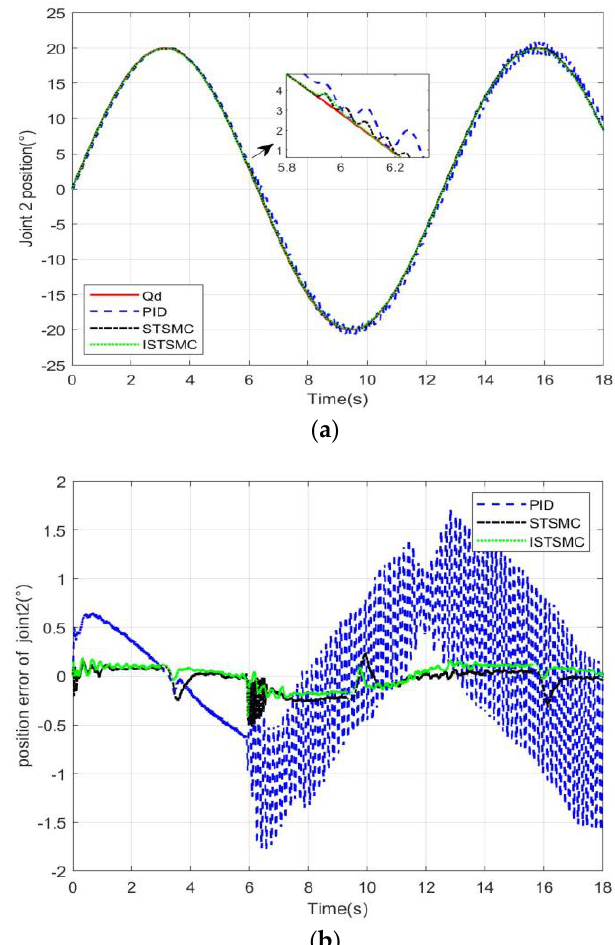
Figure 4. Joint 2 is suddenly disturbed at 5.9 s. ( a ) Trajectory tracking diagram; ( b ) trajectory tracking error diagram.